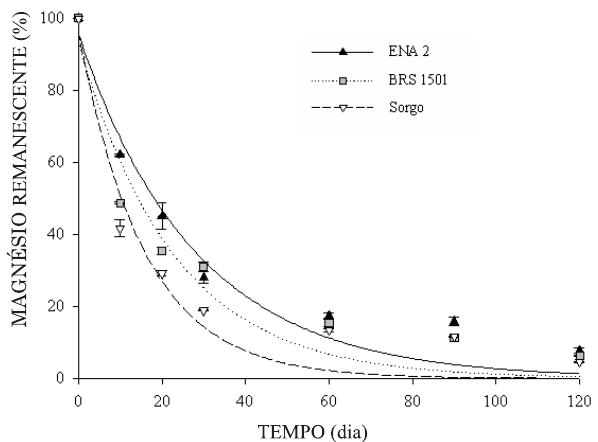
Figura 6. Teores de magnésio na matéria seca remanescente das plantas de cobertura em avaliações realizadas ao longo do tempo em bolsas de decomposição na superfície do solo (A equação e a significância dos ajustes estão apresentadas no Quadro